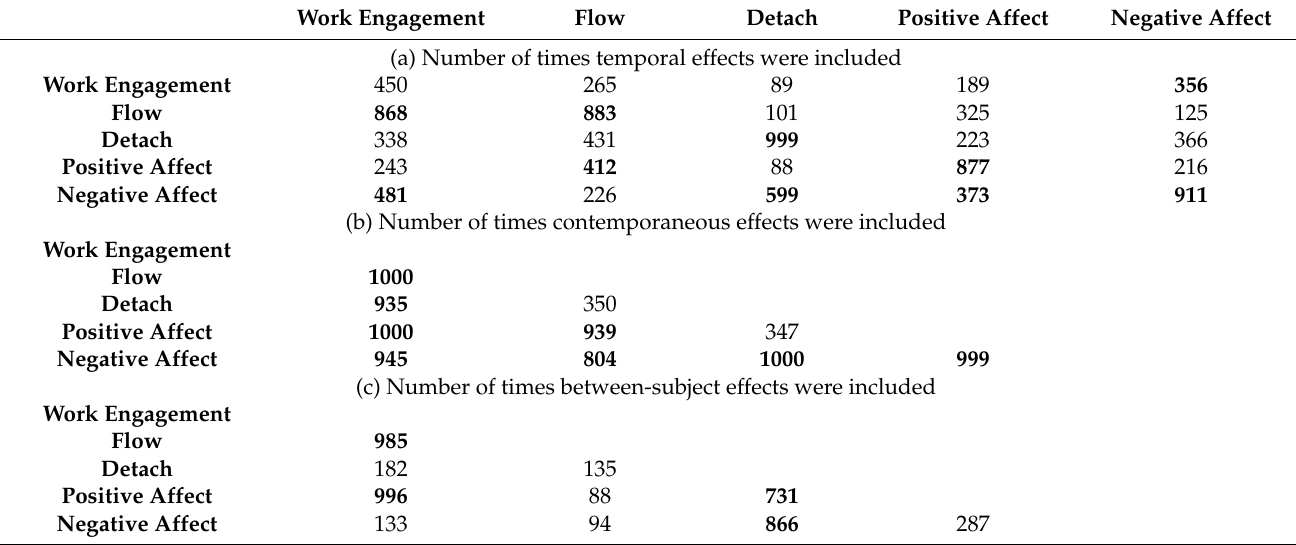
Table A2. The number of times each parameter was included in 1000 times of case-drop bootstrap (25%) analysis for the daily temporal